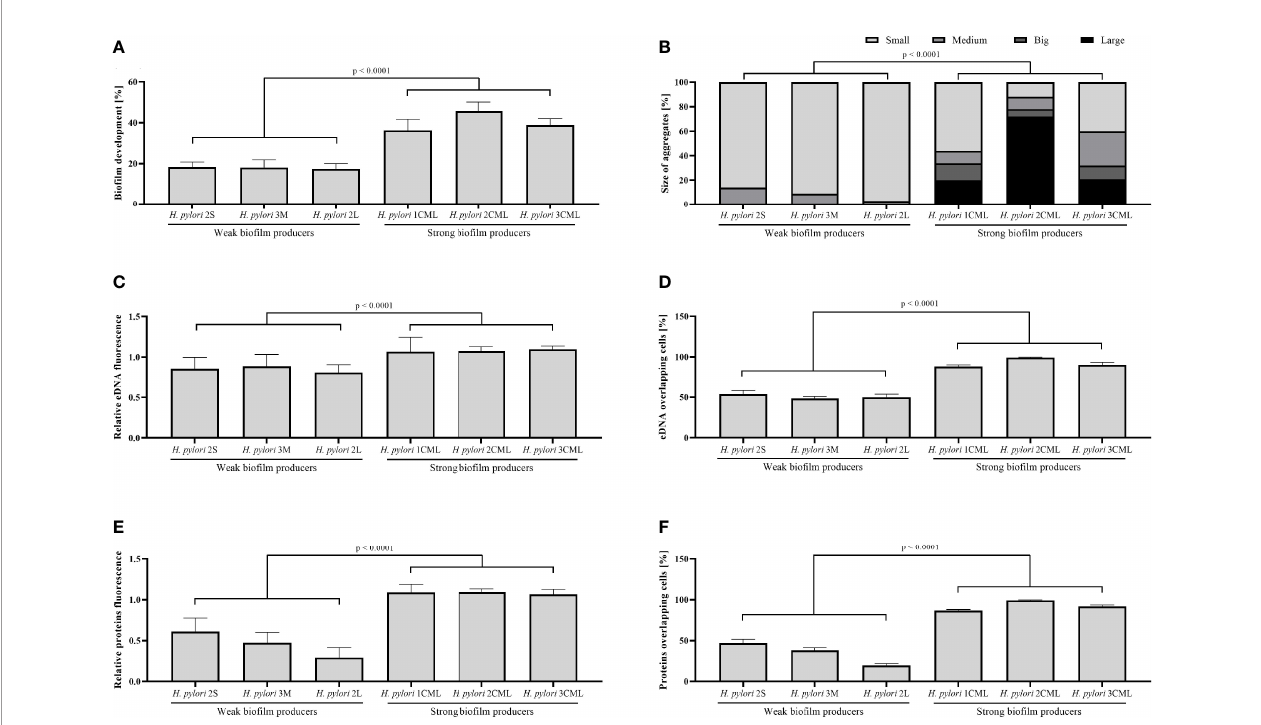
FIGURE 4 | Numerical data obtained by the analysis of bio fi lms produced by six selected H. pylori incubated for 24 h under micro fl uidic conditions. The data include bio fi lm development (A) , size of aggregates with bio fi lm (B) , relative fl uorescence of eDNA (C) and proteins (E) , and a percentage rate of eDNA (D) and proteins (F) overlapping bacterial cells in bio fi lms. The development of bio fi lm was determined based on the degree of microcapillary coverage. The fl uorescence intensity of eDNA or proteins was normalized to fl uorescence of the cellular biomass. The amount of eDNA or proteins overlapping bacterial cells was calculated based on the degree of co-localization of fl uorescence signals and indicated the rate of bacterial coverage by the matrix components. The size of aggregates was normalized to dimensions of the microcapillary canal in the examined photo and clusters of bacterial cells corresponding to > 1%, 1% - 0.5%, 0.5% - 0.1% and < 0.1% of the microcapillary size were categorized as large, big, medium and small, respectively. The total area occupied by aggregates of a give category was calculated and presented as a percentage share in all aggregates formed. The micro fl uidic assays were performed in six biological replications with three technical repetitions constituting three different fragments of microcapillaries (n =